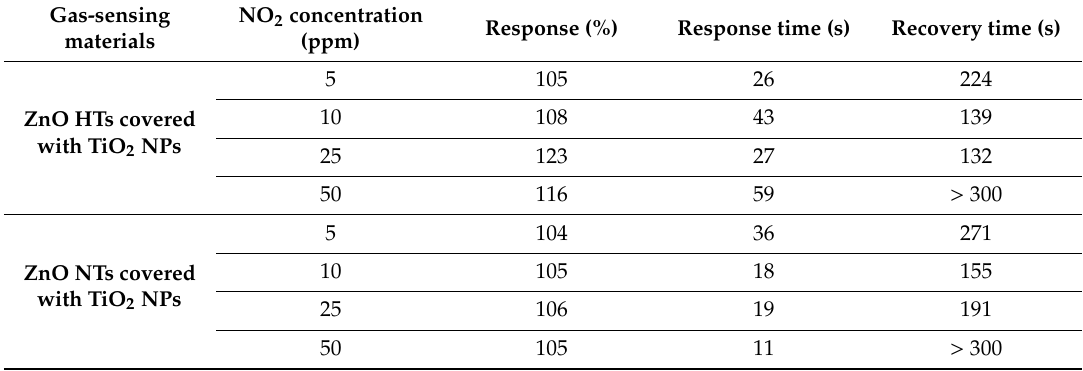
Table 2. Gas-sensing properties of ZnO HTs and ZnO NTs covered with TiO 2 NPs gas sensors as gas